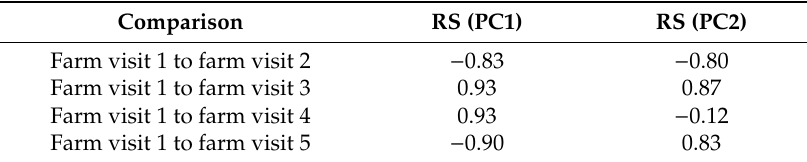
Table 4. Spearman’s rank correlation coe ffi cient (RS) for the comparison of the factor loadings on the first two principal components (PC; PC1 and PC2) between farm visits.